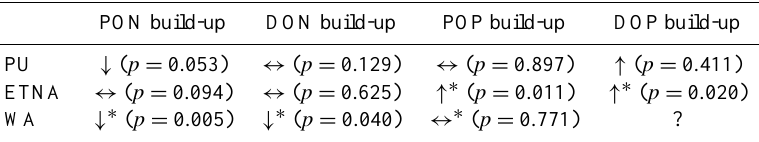
Table 5. Summarizing the effect of decreasing N : P supply on accumulation of PON, DON, POP and DOP within each experiment. Statistical significance of the individual effect ( p < 0 . 05; denoted by ∗ ) was tested with linear regression analysis and p -values are given in